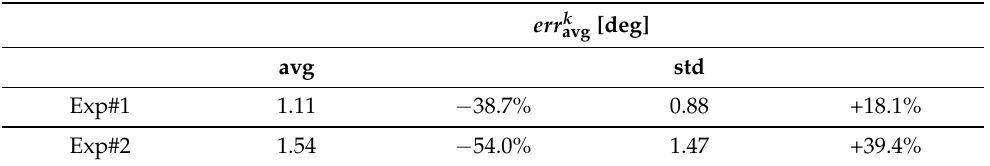
Table 4. Statistical indexes of the absolute AoA estimation errors after compensation for antenna couples {23} and {43}. err k [deg] err k [deg] 23 43 avg std avg std Exp#1 1.78 Exp#2 Table 5. Statistical indexes of the absolute AoA estimation errors after averaging the estimated AoAs after compensation for antenna couples {23} and {43}. err k avg [deg] avg std Exp#1 1.11 − 38.7% 0.88 +18.1% Exp#2 1.54 − 54.0% 1.47